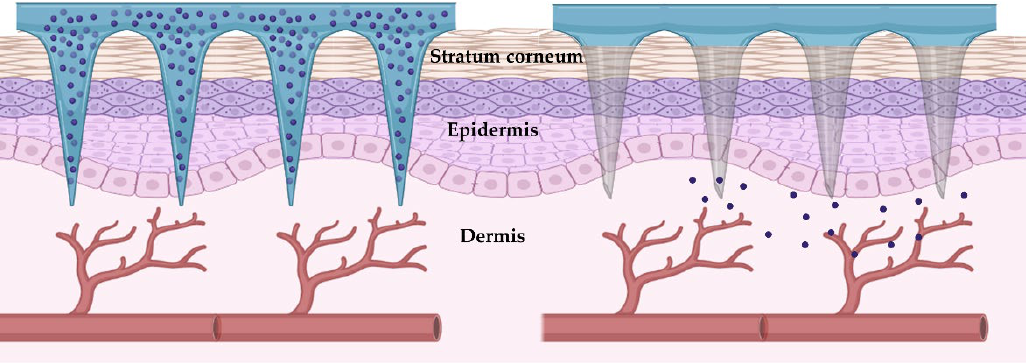
Figure 5. Schematic representation of the hydrogel-forming microneedles’ application and release. Different approaches have been developed using hydrogel-forming